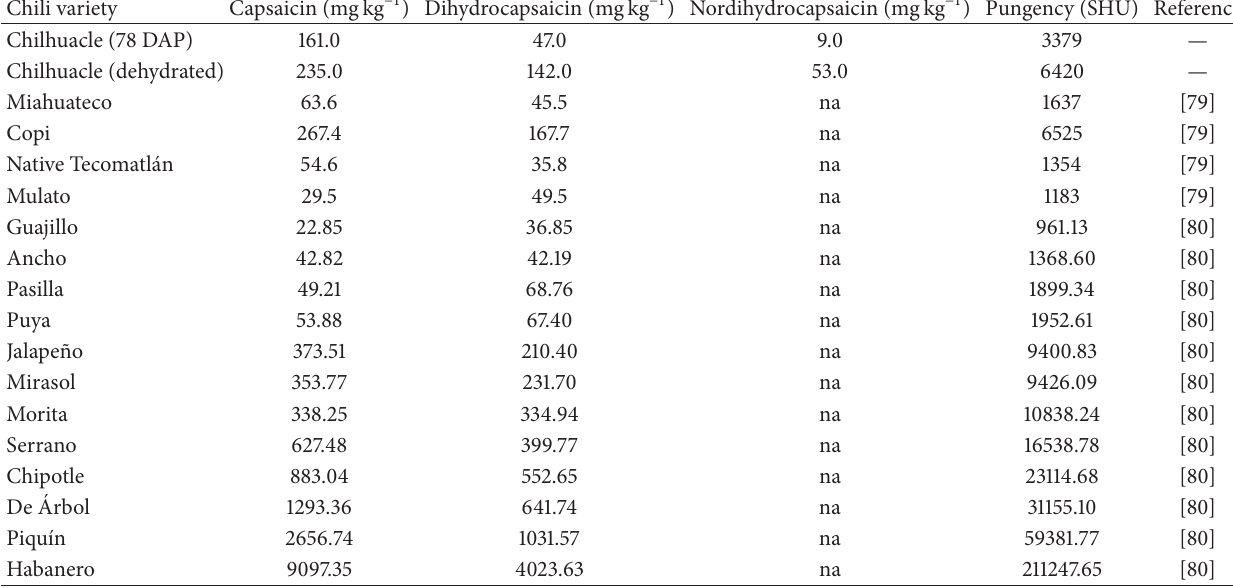
Table 2: Capsaicin and capsaicinoid concentrations and pungency of different chilies native to Mexico. Chili